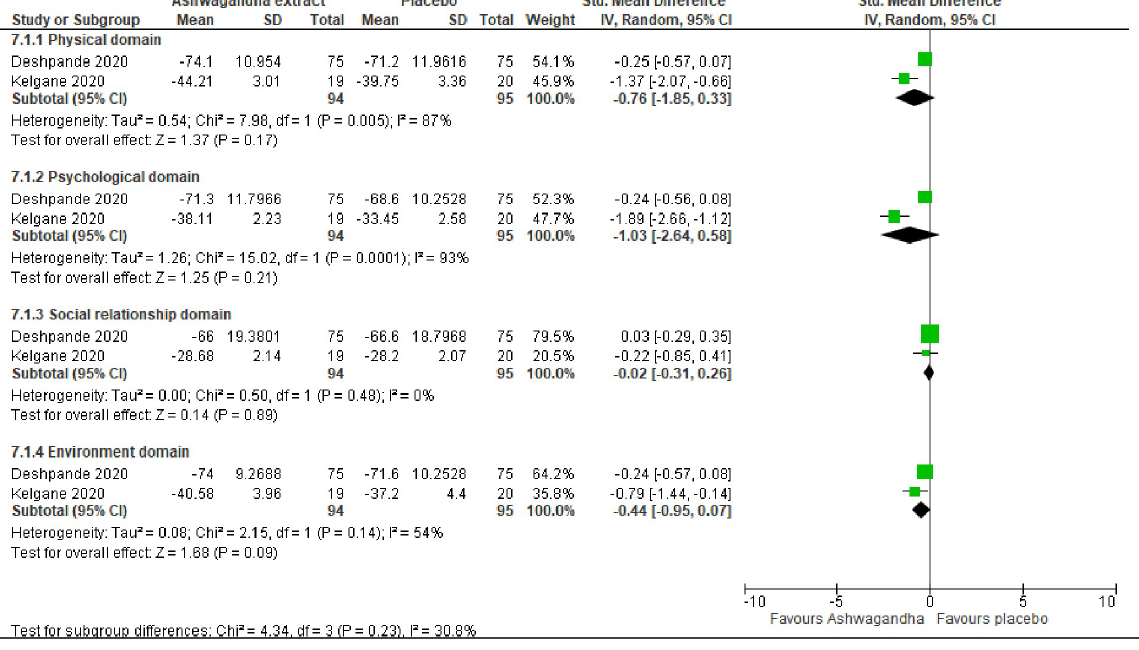
PLOS ONE | https://doi.org/10.1371/journal.pone.0257843 September 24,